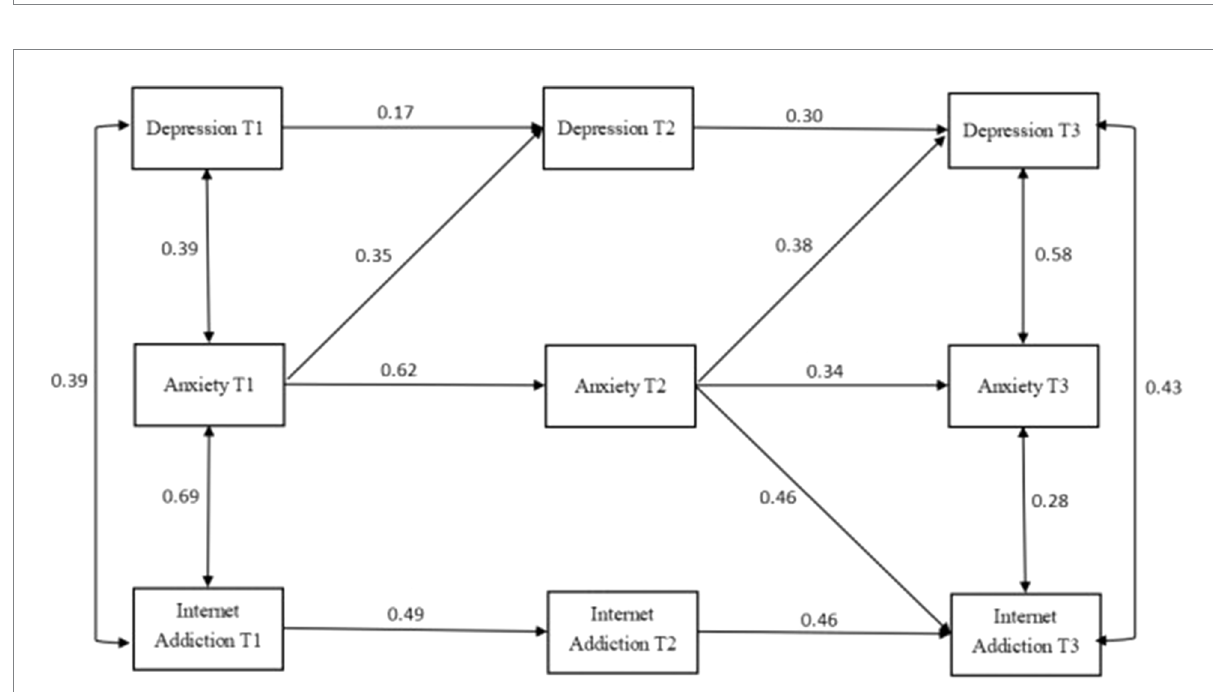
FIGURE 3 Cross-lagged analysis of depression, anxiety, and Internet addiction among men. T1 is the baseline data and T2 and T3 are follow-up data. The solid line indicates statistical